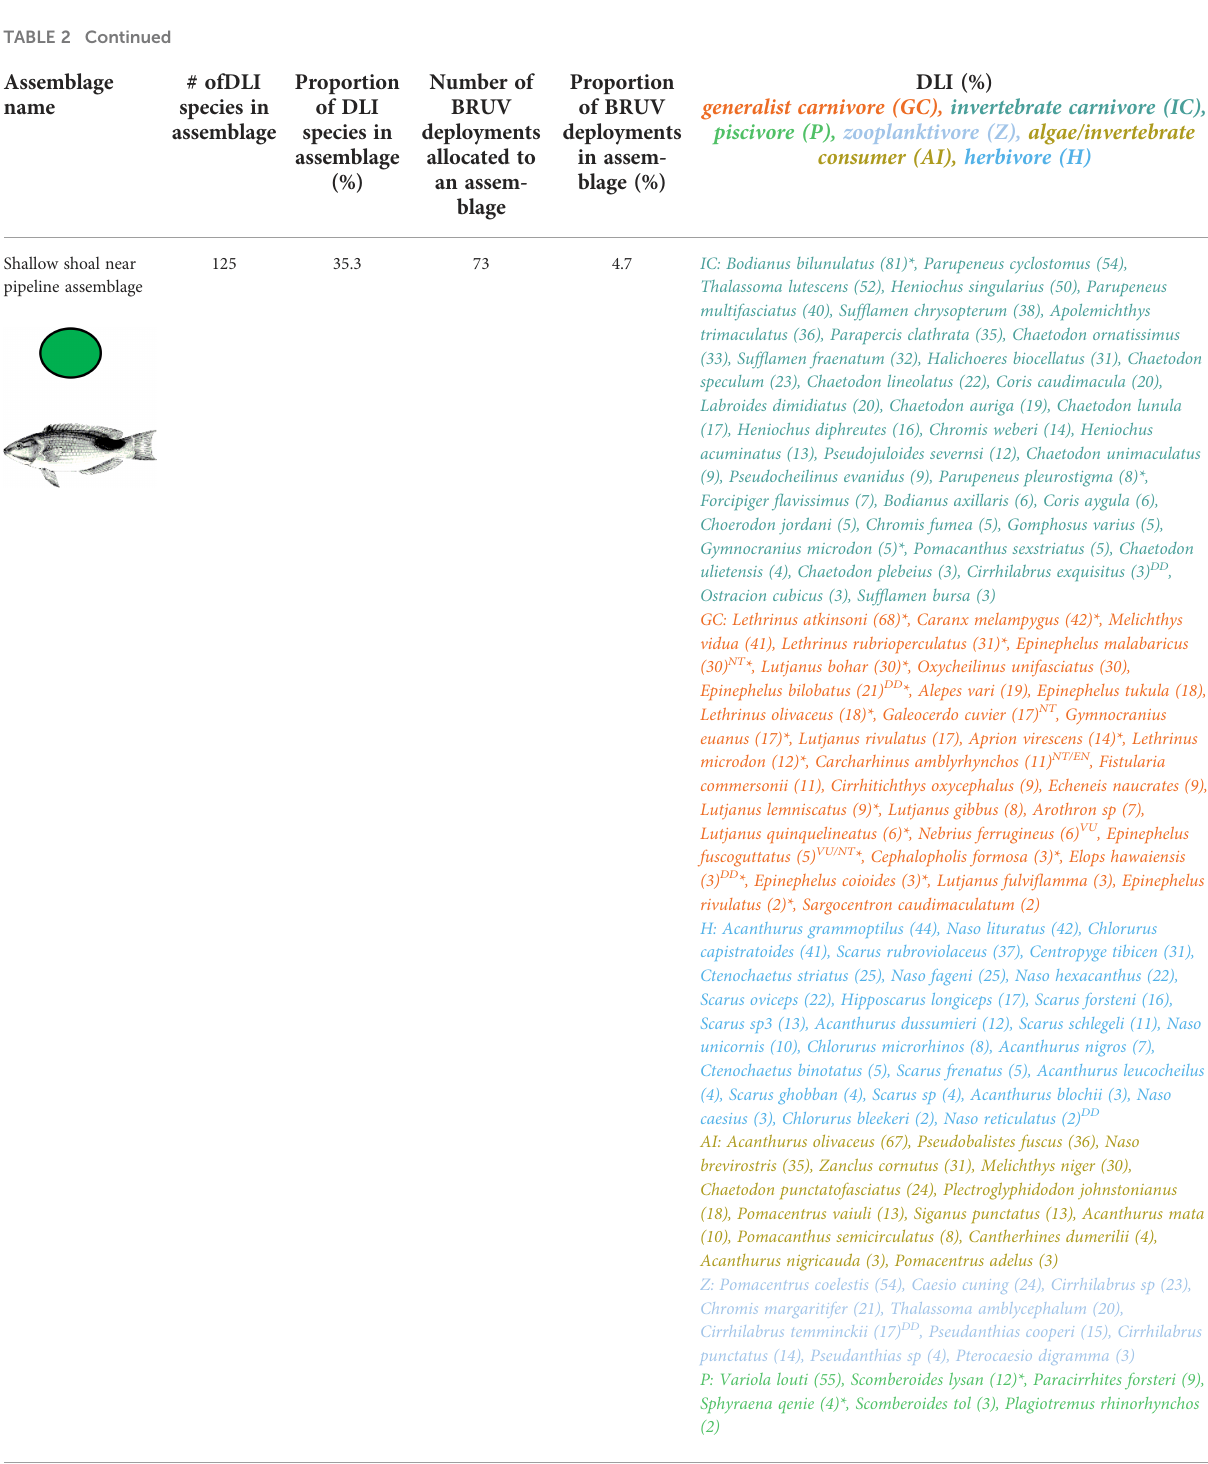
Values of the Dufrene-Legendre index (DLI) for each discriminant taxa are shown in brackets with asterisk (*) indicates commercial taxa. The higher DLI value (100 being the highest) the more ‘ indicative ’ the taxa is of a speci fi c assemblage. Coloured circles match terminal nodes indicated in Figure 4 and mapped in Figure 5. Threatened taxa under IUCN Red List are indicated with superscript: data de fi cient (DD), near threatened (NT), vulnerable (VU), endangered (EN), critically endangered (CR). Text colours represent feeding guilds: generalist carnivore, invertebrate carnivore, piscivore, zooplanktivore, algae/invertebrate consumer,